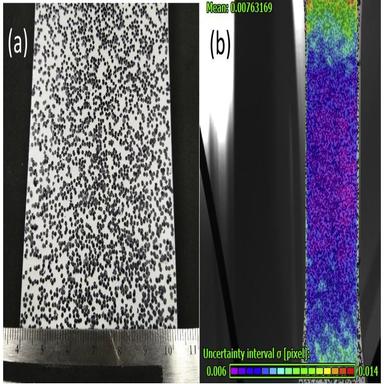
(a) Speckle pattern applied on the tensile test specimen. (b) Uncertainty in the correlation of subsets in images.